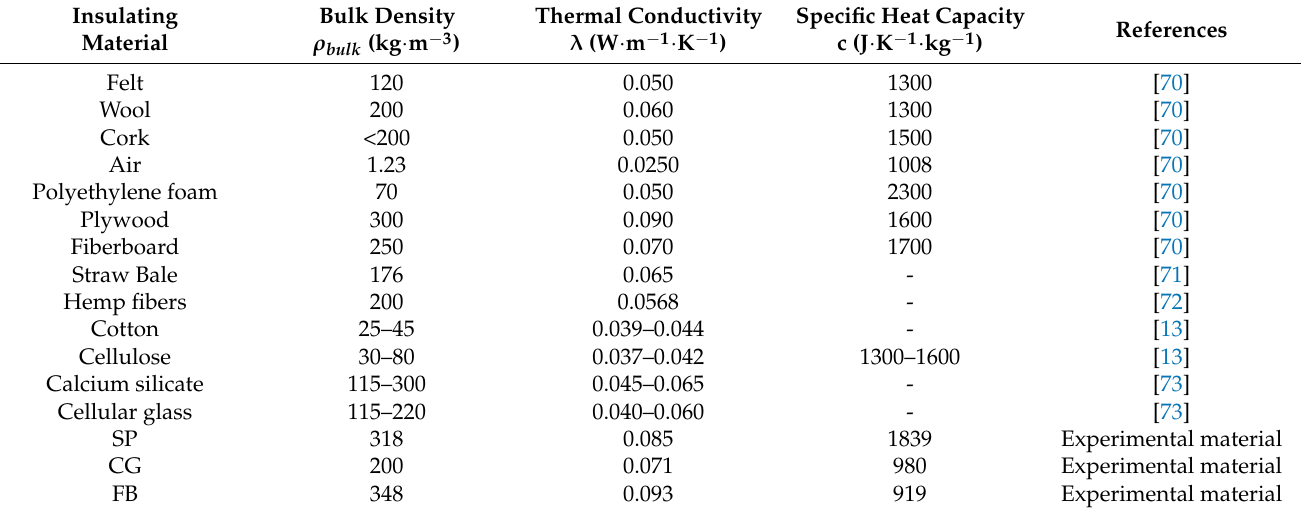
Table 4. Comparison between traditional components and experimental